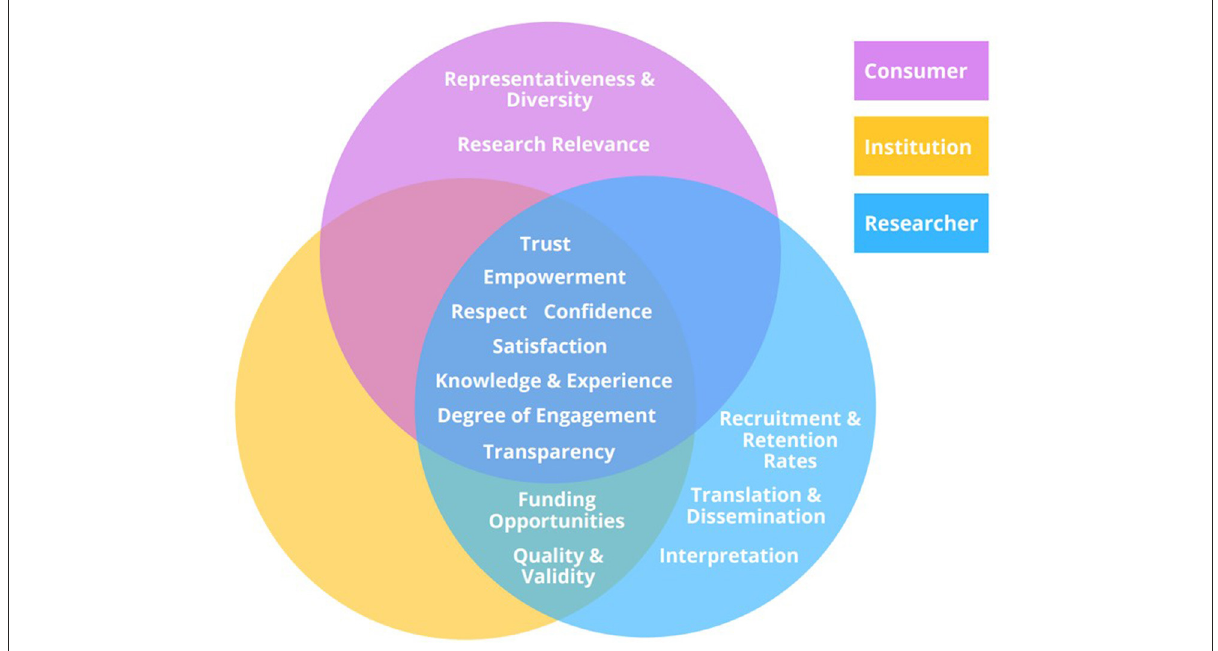
FIGURE2 Measurable outcomes of consumer engagement mapped to relevant